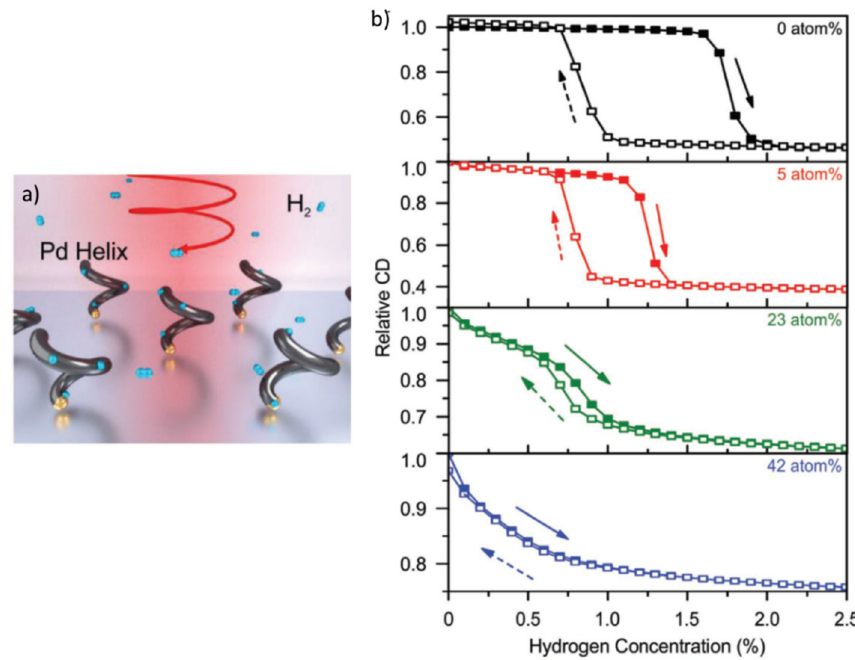
Figure 9. ( a ) Schematic illustration of plasmonic nanohelices for H 2 sensing. ( b ) Circular dichroism signal of PdAu nanohelices, having different Au fraction, as a function of H 2 concentration. Reproduced from [90], with permission from Wiley, 2018.